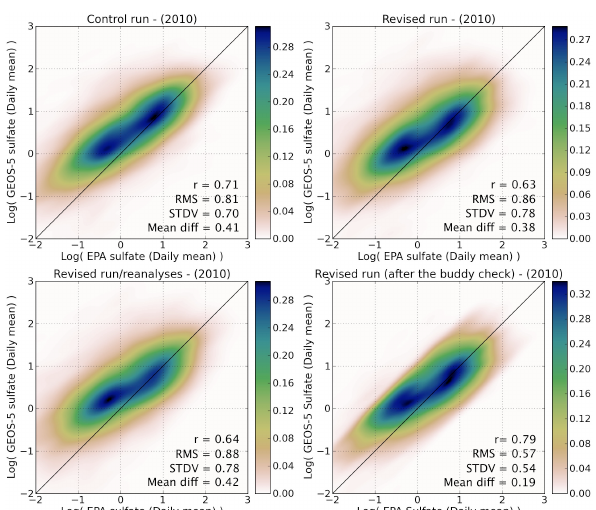
Fig. 6. Comparison of daily averaged sulfate surface concentrations for 250 EPA sites in 2010. The model results are from the control run, the revised run, the aerosol assimilation system and the revised simulations combined with the buddy check of Dee et al. (2001).